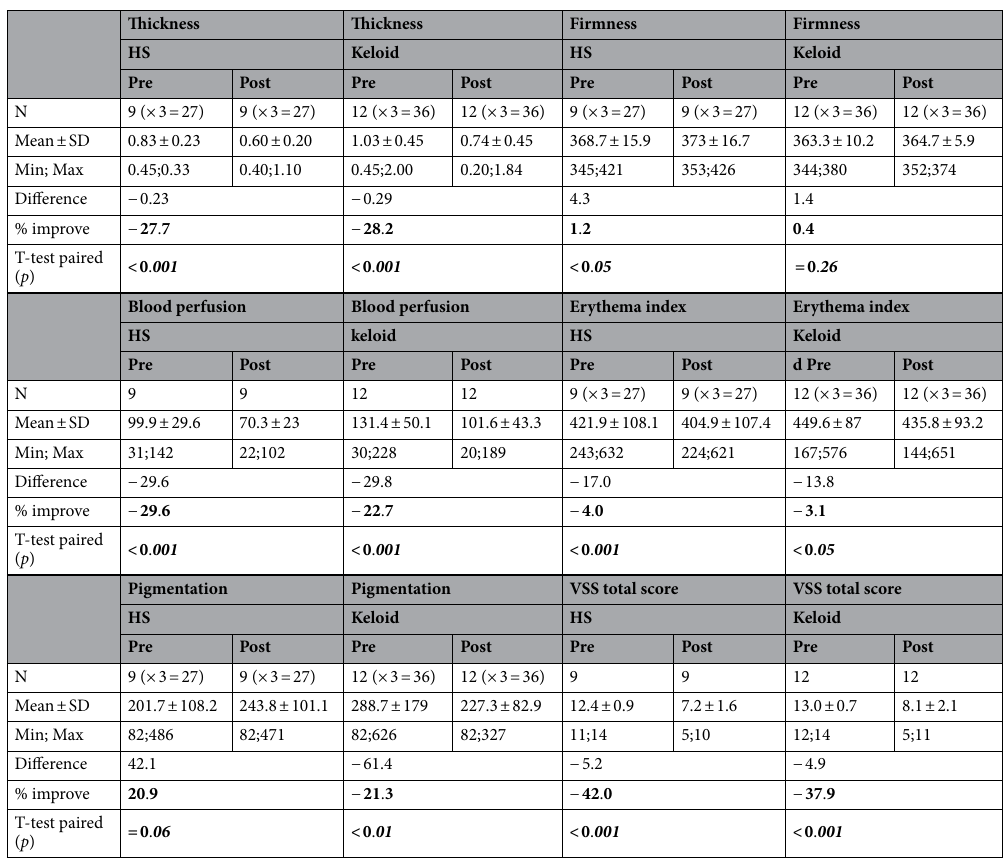
Table 3. Hypertrophic scar and keloid subgroups: modifications and improvement percentages, pre and post laser